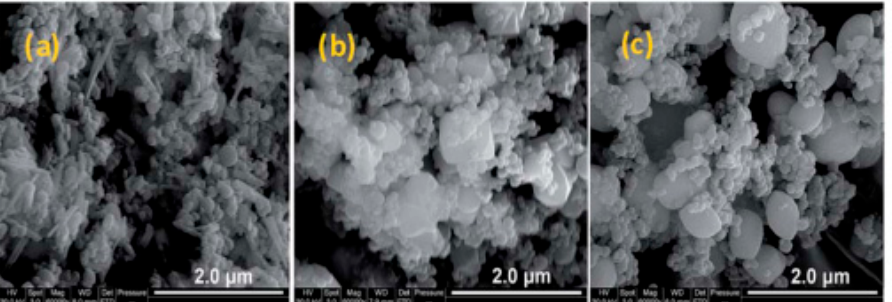
Figure 5-9. ( a , b ) SEM images of nano-Fe 2 O 3 and superthermite Al/Fe 2 O 3 ; ( c ) DSC curves of RDX and RDX/superthermite (Al/Fe 2 O 3 ) mixture. ( a – c ) Reproduced with the permission of ref. [153]. Copy- right 2013, Acta Physico-Chimica Sinica.